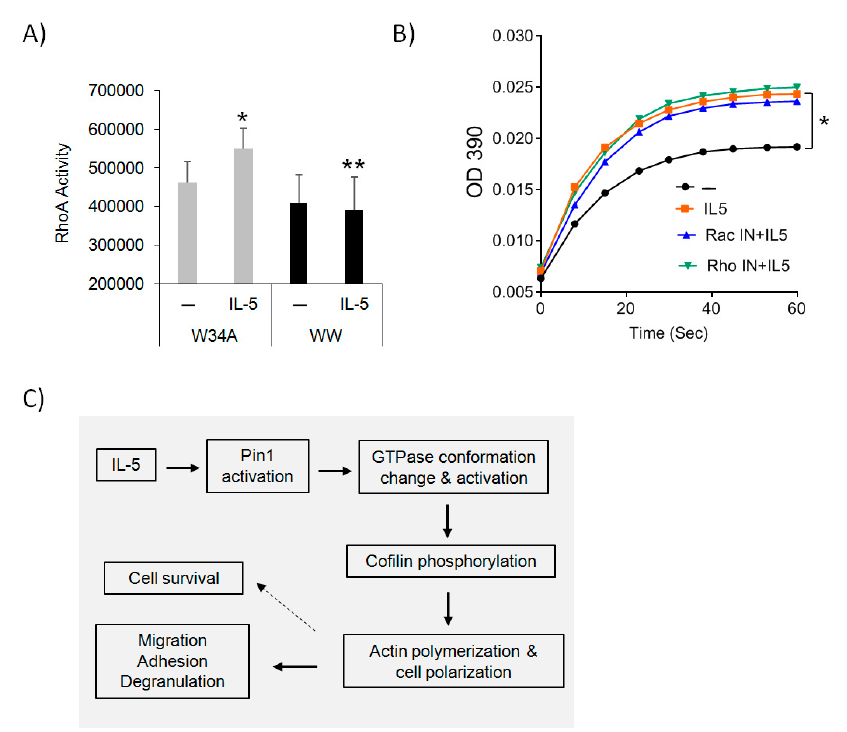
Figure 6. Pin1 regulates GTPase activity. ( A ) Purified human peripheral blood Eos were starved and incubated with TAT-WW (100 nM) or control peptides (TAT-W34A) for 1 h before treatment with hIL-5 (5 ng/mL) for 10 min. The activity of RhoA was measured using commercial G-LISA kit (Cell Biolabs Inc.). Data are from three independent experiments. * p < 0.05 between untreated (–) and IL-5 in W34A-treated cells, ** p < 0.05 between IL-5 groups. ( B ) Human blood Eos were starved and incubated with RhoA (30 μ M) or Rac inhibitor (100 μ M) for 2 h before treatment with hIL-5 (5 ng/mL) for Pin1 isomerase activity assay. * p < 0.05 between untreated (dark circle) and IL-5 treatment (red square). There were no significant differences between IL-5 and RacIN+IL-5 or RhoIN+IL-5. ( C ) The proposed model for Pin1 regulation of Eos polarization and migration. Pin1 is rapidly activated by IL-5, which allows Pin1 to interact with and isomerize GTPases, resulting in conformational change and increased GTPase activity towards downstream targets.